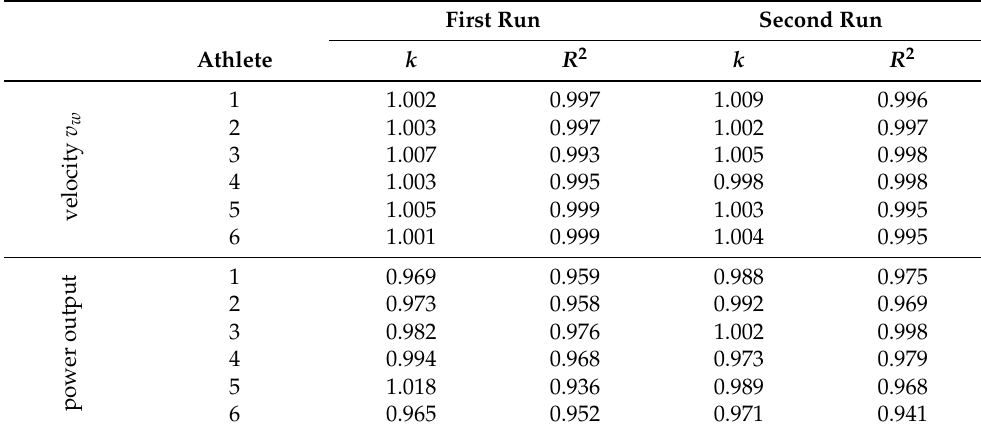
Table 2. Correlation between the modelled and measured data of cycling velocity v w and power output with the corresponding coefficient of determination R 2 ( n = 6).